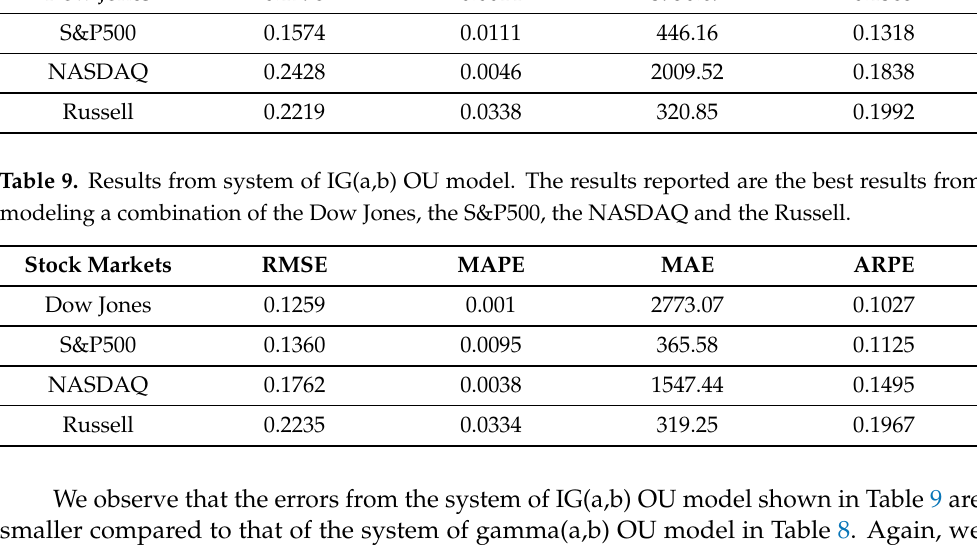
Table 8. Results from system of Γ ( a , b ) OU model. The results reported are the best results from modeling a combination of the Dow Jones, the S&P500, the NASDAQ and the Russell. Stock Markets RMSE MAPE MAE ARPE Dow Jones